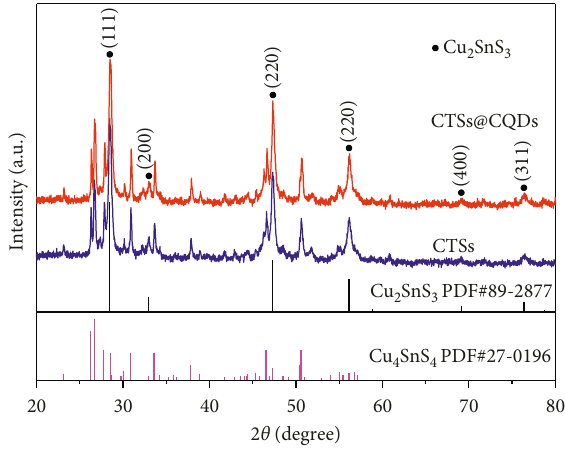
Figure 1: XRD patterns of CTSs and